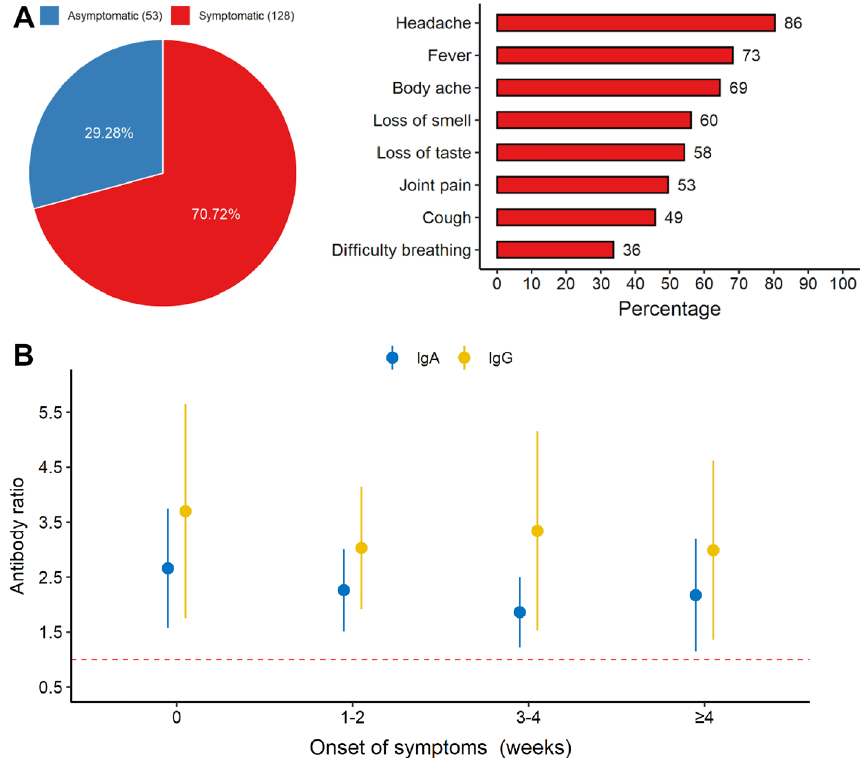
Figure 3. Main clinical symptoms and pattern of positivity according to the day of onset of the individual’s symptoms. ( A ) Number of symptomatic and asymptomatic individuals positive for SARS-CoV-2. ( B ) IgA and IgG positivity rates according to the day of the onset of the symptoms. Number 0 means the individuals presented symptoms on the day of blood collection. Dots and vertical lines represent mean and standard deviation, respectively. Dashed line represent cut-off values specified by the